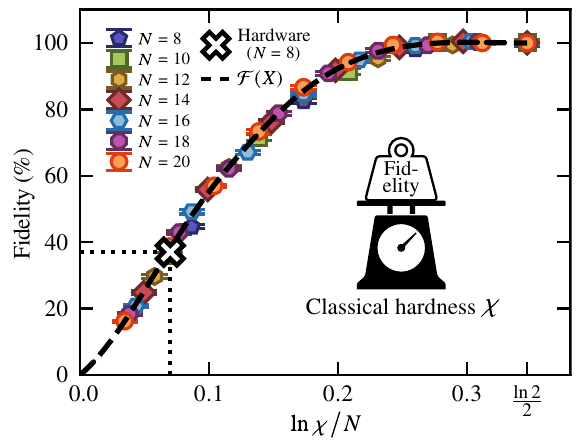
FIG. 1. A summary of the main results of this work. We per- form MPS simulations with bond dimension χ of the QAOA for the Max-Cut problem on N qubits. The best output cost that the algorithm seeks to minimize is used for defining the “fidelity” as (cid:4) (cid:2) (cid:4)(cid:3) (cid:2) , where χ exact = 2 N / 2 is the bond the ratio C N , χ C N , χ exact dimension required for exact calculations. Each data point cor- responds to the statistical average of 100 QAOA instances with one layer on random 3-regular graphs. Plotting the data as a func- tion of X = ln χ/ N makes them collapse onto a single curve Y = F ( X ) , thus revealing a scaling relation. For instance, by on N = 8 qubits to the scaling function, one obtains a measure (cid:13) (cid:12) F − 1 ( Y ) N ≈ 2 of of the classical hardness χ = exp